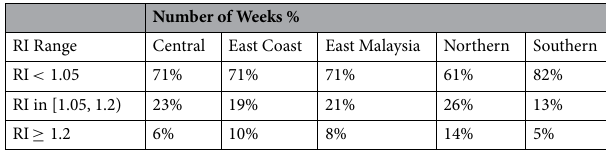
Table 4. Weekly RIs statistics Summary.